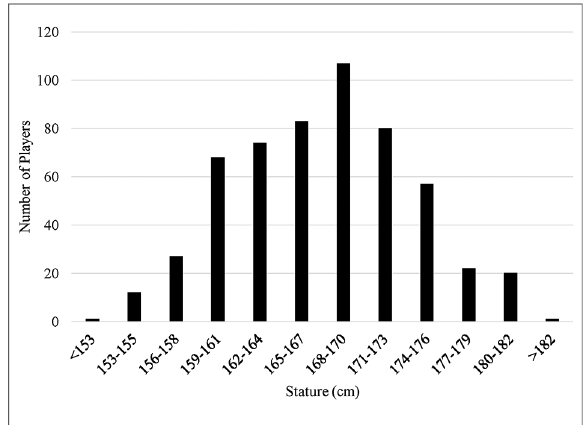
FIGURE 1 Overall breakdown of the statures of 552 players representing 24 countries in the 2019 FIFA Women ’ s world Cup games.